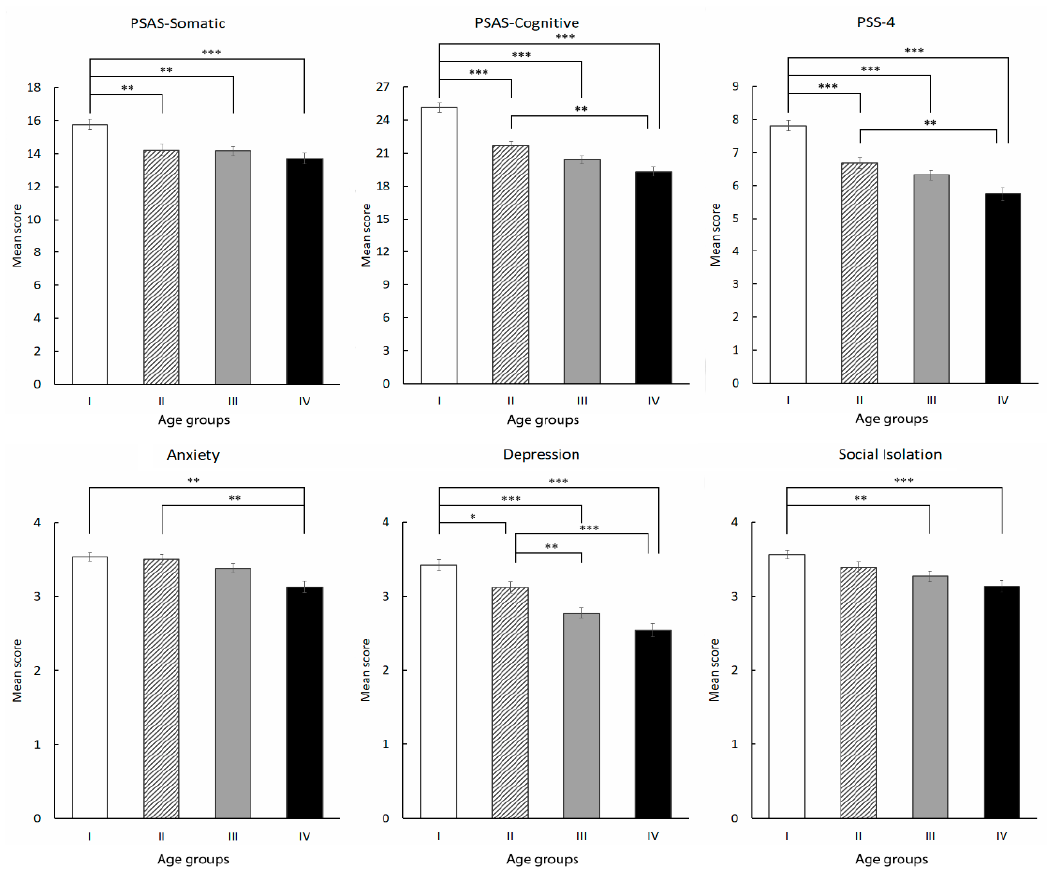
Figure 2. Mean scores of psychosocial variables by age groups. * p < 0.05; ** p < 0.01; *** p < 0.001. PSAS-Somatic, Somatic pre-sleep arousal; PSAS-Cognitive, Cognitive pre-sleep arousal; PSS-4, Per- ceived stress scale-4. Age categories: I—18–29 years, II—30–41 years, III—42–53 years, and IV—54–70 years old.